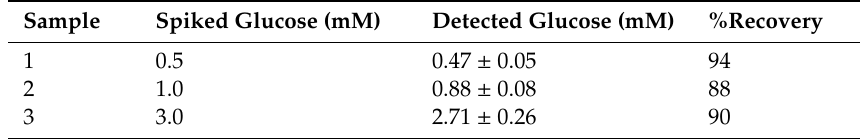
Table 2. Determination of glucose in human blood serum